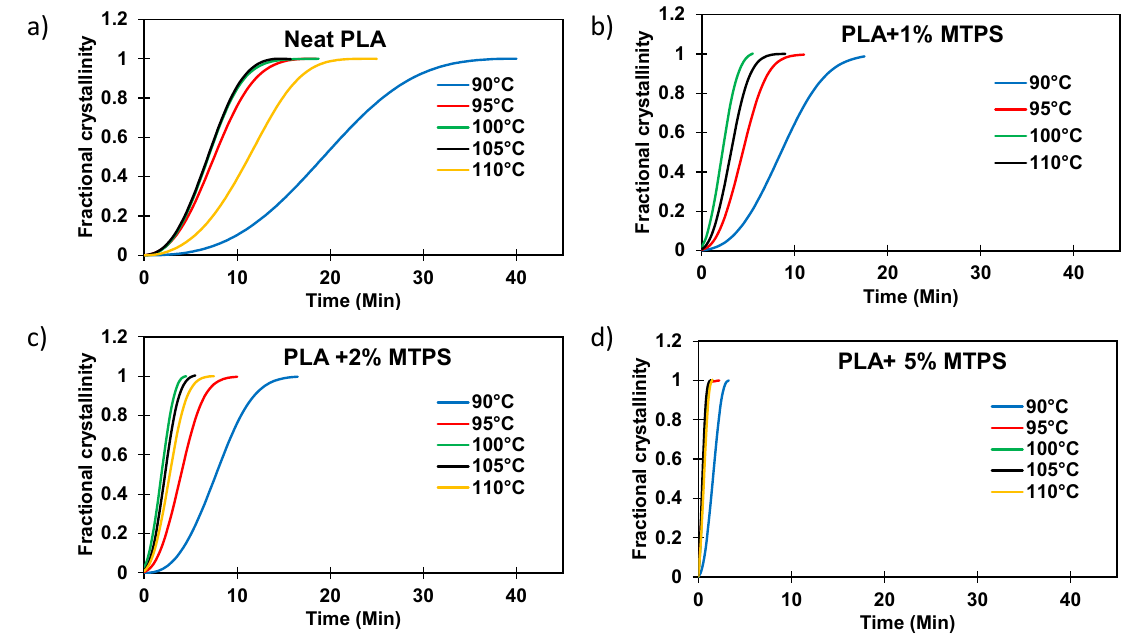
Figure 11. Fractional crystallinity vs. time of ( a ) PLA and blends ( b ) PLA + 1%MTPS, ( c ) PLA + 2%MTPS, ( d ) PLA + 5% MTPS at various temperatures.